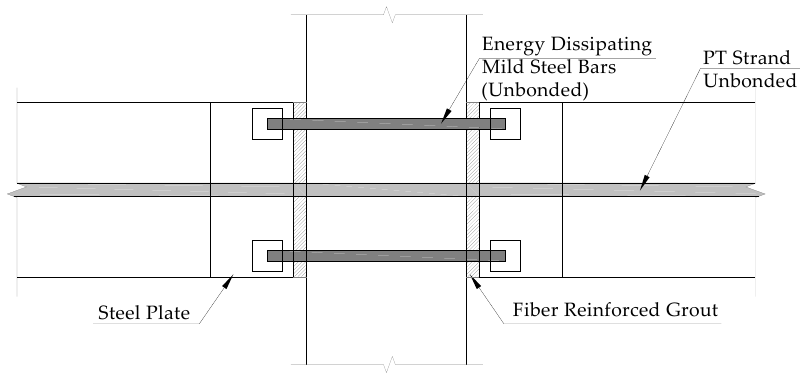
Figure 25. Proposed precast post-tensioned beam column connection [48].